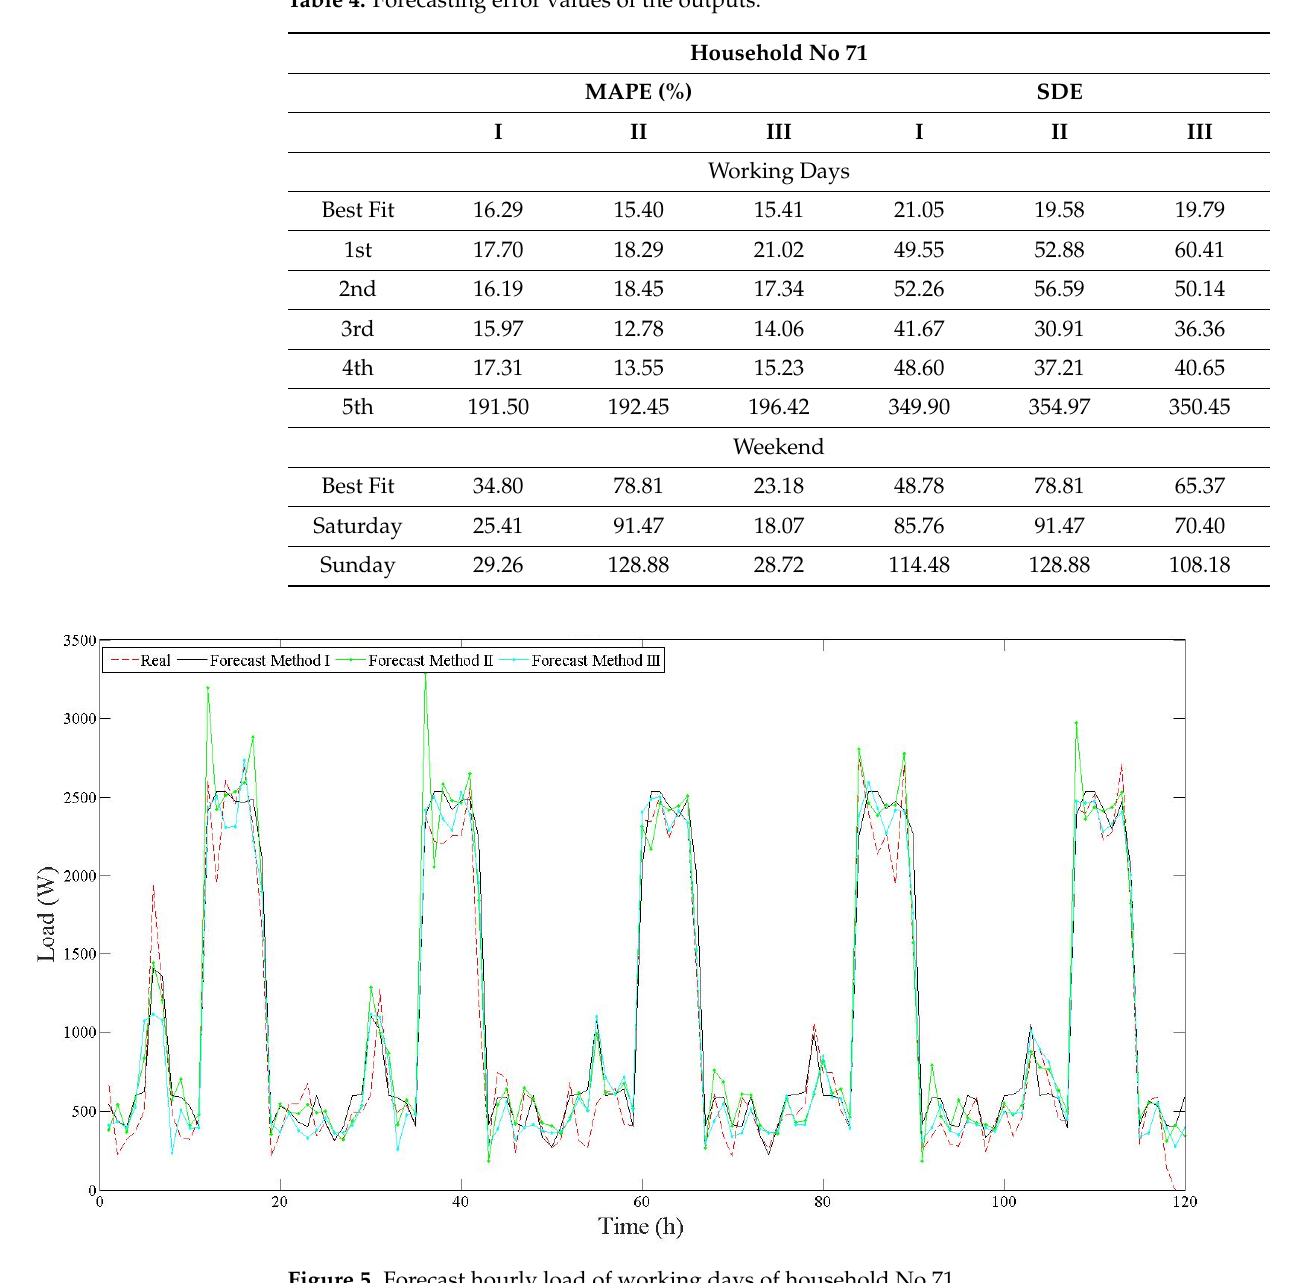
Table 4. Forecasting error values of the outputs.